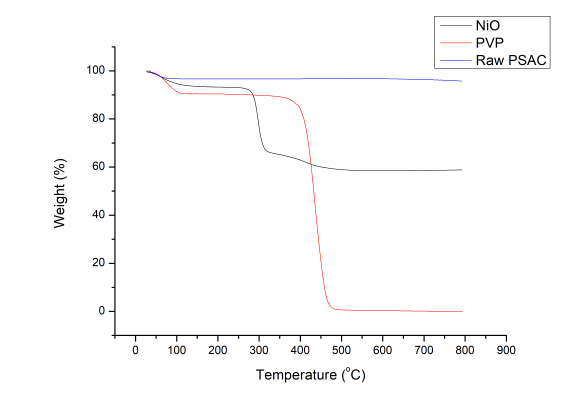
Fig. 3. TGA profiles of raw PSAC, NiO nps and